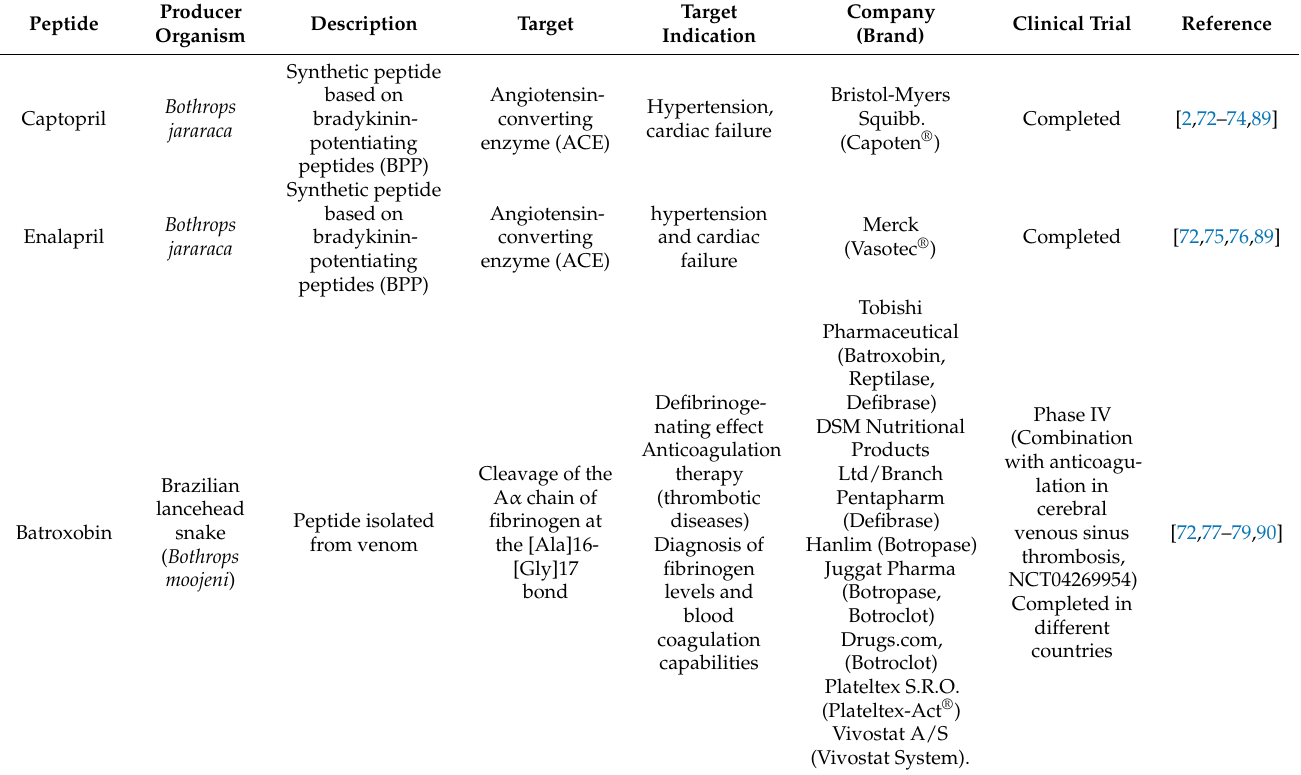
Table 2. Clinical or preclinical status of venom-derived peptides from South America. Extended overview of the producer organism, description of the peptide, main biological target, target indica- tion, company and brand, and clinical trial stage of the venom-derived